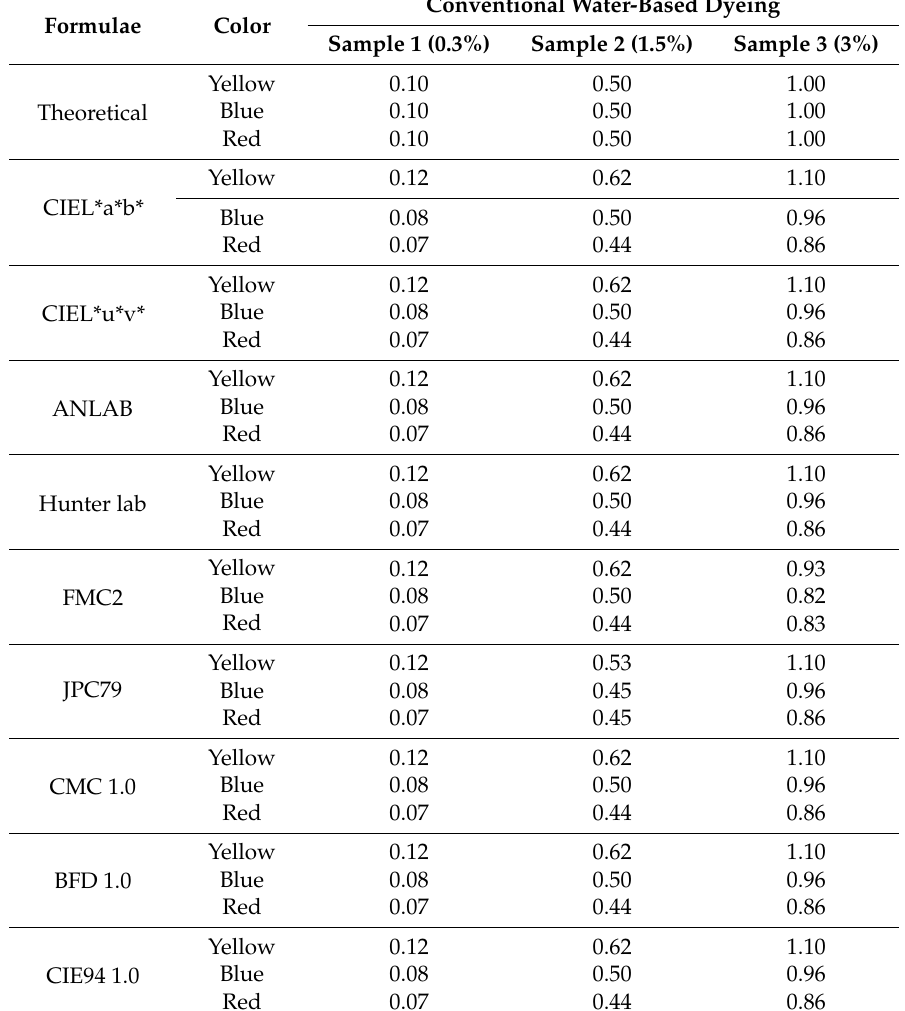
Table 6. Color matching recipes of water-based dyed standard samples with different color difference